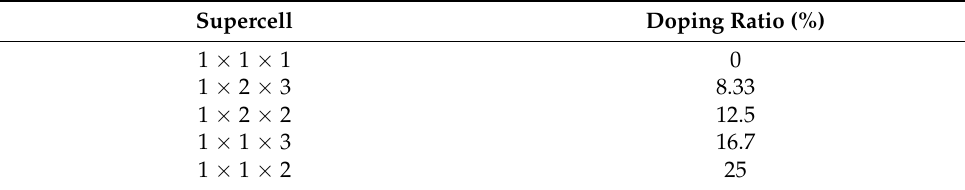
Figure 1. Cell model. Table 1. Doping ratio and supercell